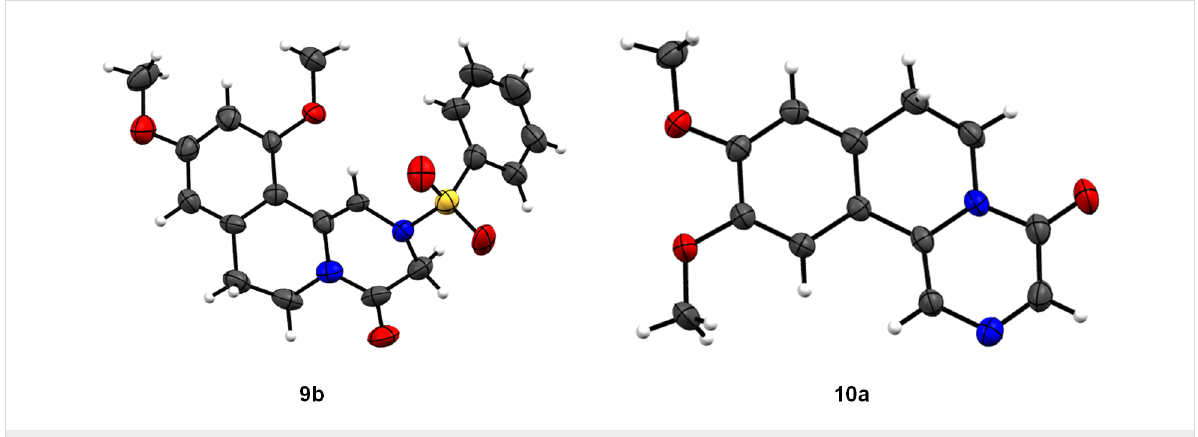
Figure 3: ORTEP diagrams of compound 9b and 10a .